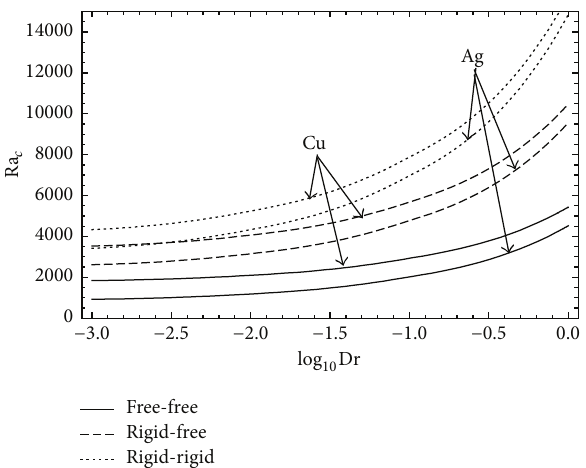
Figure 2: Plot of Ra 𝑐 with Darcy number for fixed 𝑄 = 250 and 𝜀 = 0.4